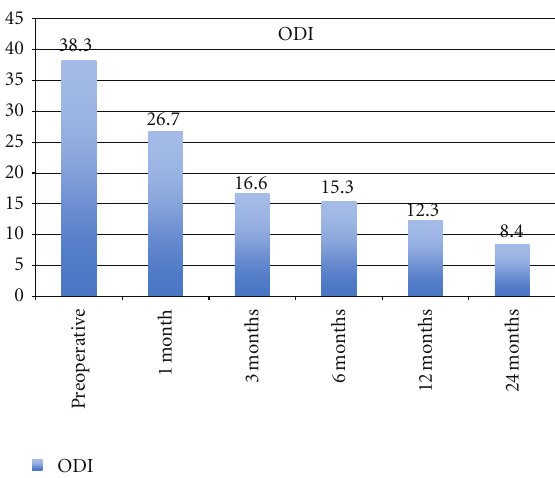
Figure 6: Pain Visual Analogue Scale (VAS) (Leg and Back) at Baseline and 1, 3, 6, 12, and 24 months after